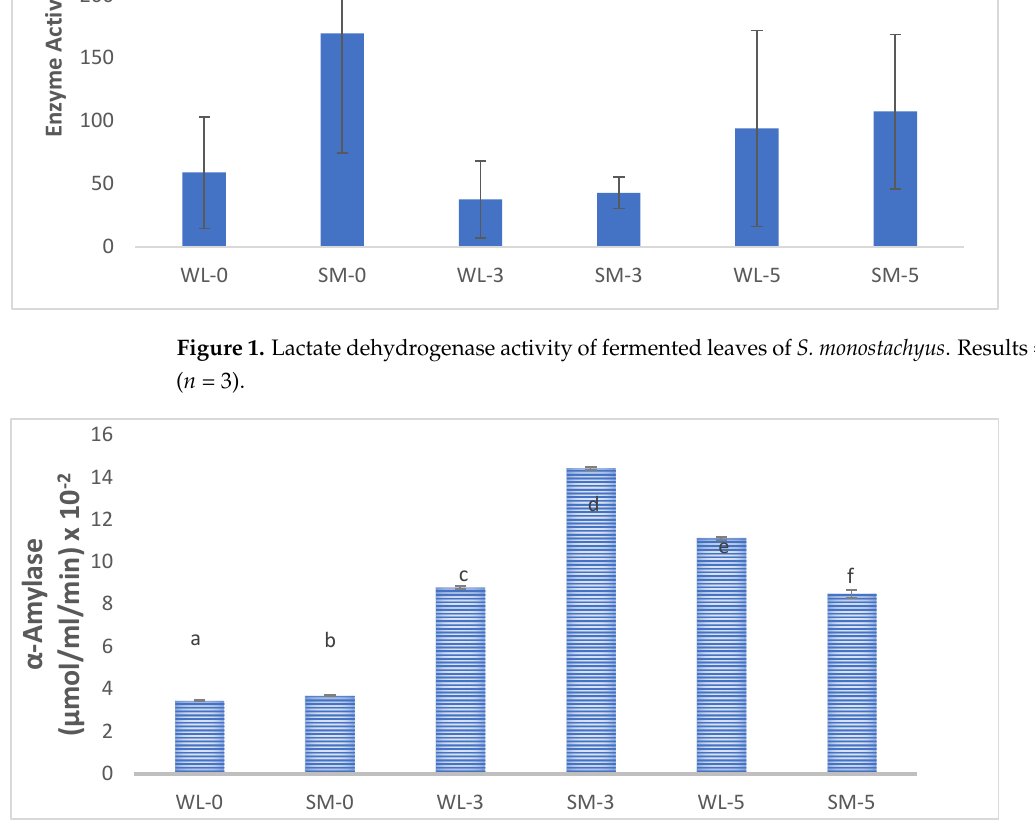
Figure 2. α-Amylase activities in fermented leaves of S. monostachyus . Results = mean ± sd ( n = 3). a–f The results with different superscript alphabets are significantly different ( p < 0.05). Keys: SM = S. monostachyus ; WL = water leaf ( T. fruticosum ).